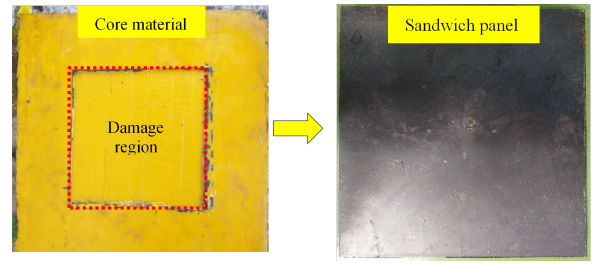
Figure 3: Assembly of the debonded